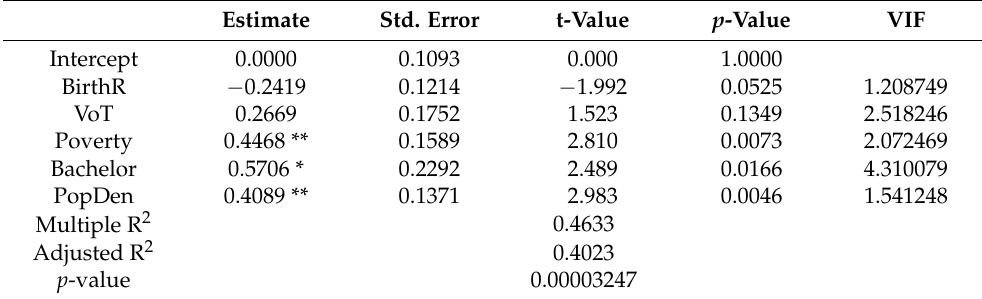
Table 2. Summary of stepwise OLS